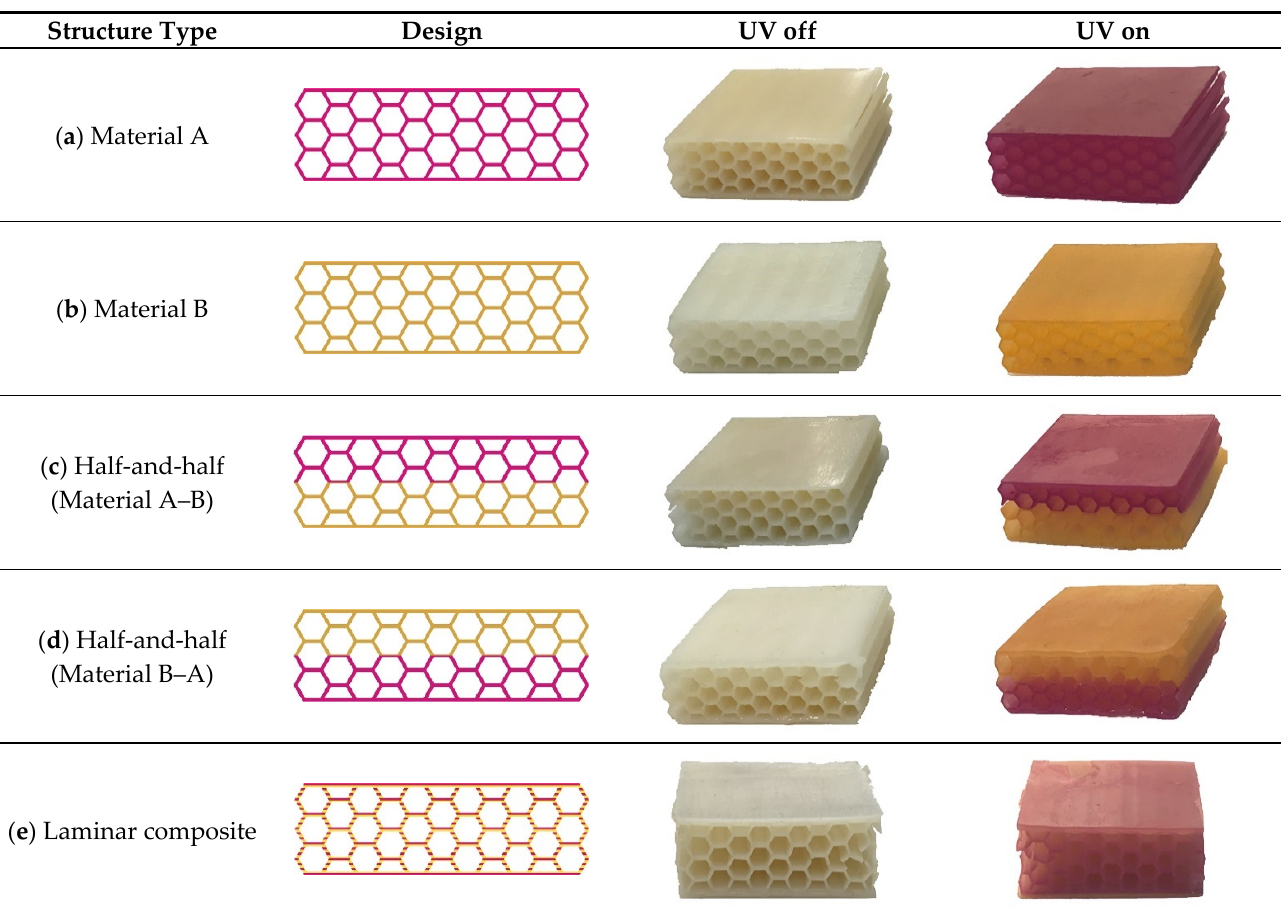
Figure 13. Specimens in the ball rebound test.